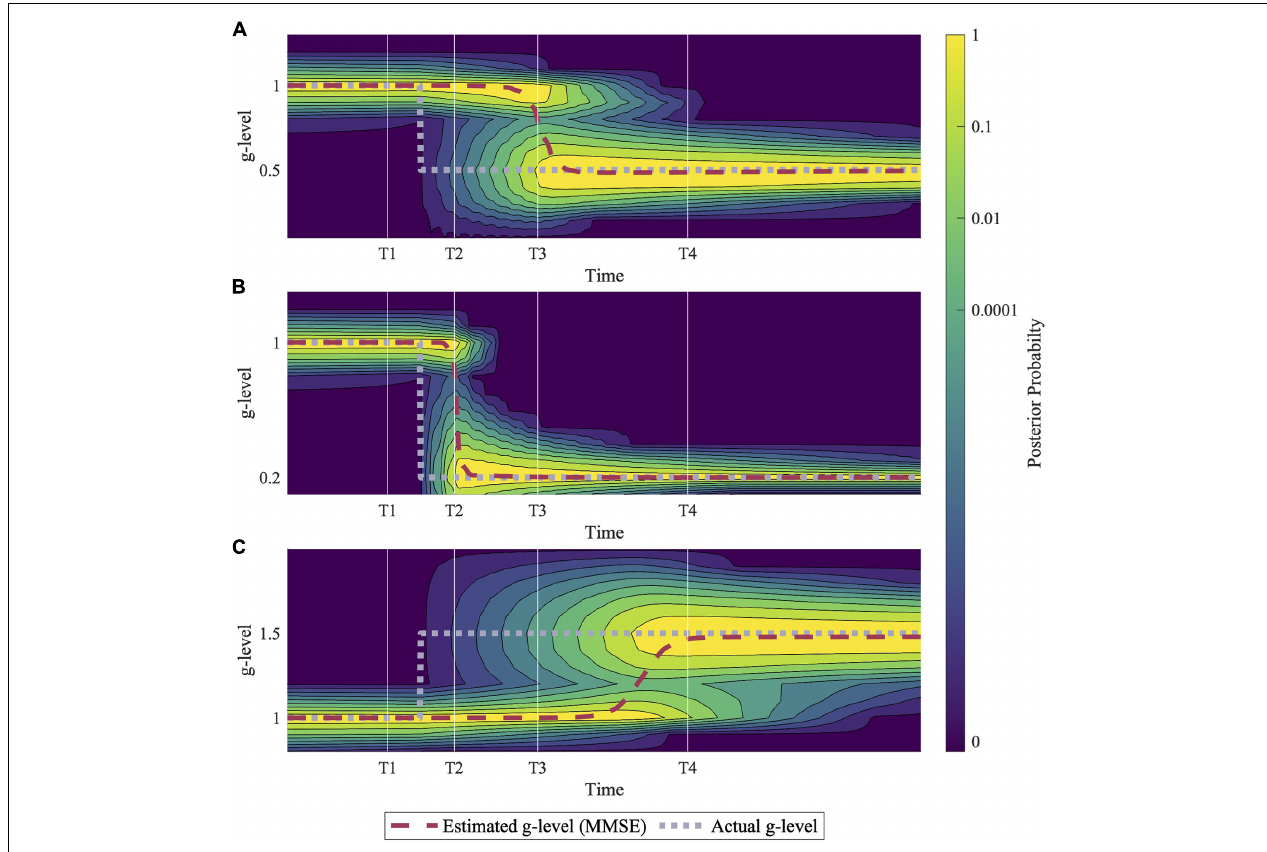
FIGURE 4 | Example simulations of hypo- and hyper- gravity adaptation scenarios. (A) Shows an adaptation to 0.5 g , (B) shows adaptation to 0.2 g , and (C) shows adaptation to 1.5 g . Simulation results suggest that adaptation to hyper-gravity (1.5 g ) from 1 g may take longer than adaptation to hypo-gravity (0.5 g , 0.2 g ). Each simulation was completed using a sinusoidal roll-tilt (30 ◦ , 0.25 Hz) motion